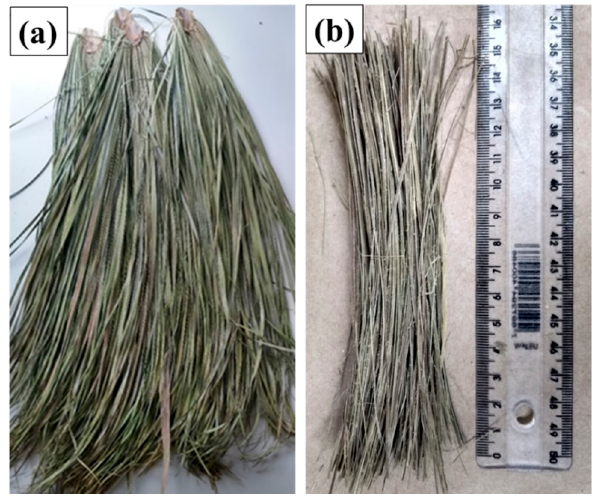
Figure 2. Macroscopic aspect of carnauba: ( a ) As received leaf-stalks and ( b ) shredded fibers.